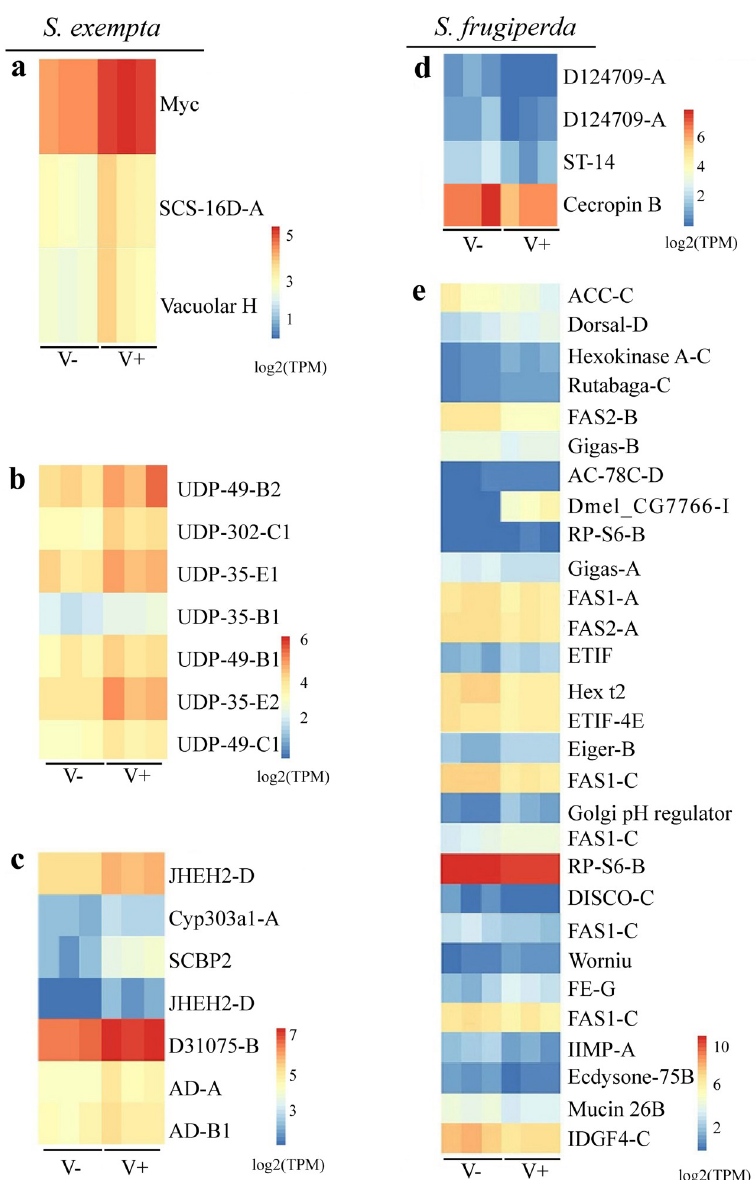
Fig 6. The quantity of DEGs with log2(TPM) related to the expression of different pathways. (a) the Jak-STAT signaling pathway of S . exempta larvae; (b) the Insect hormone biosynthesis pathway of S . exempta adult females; (c) the Steroid hormone biosynthesis pathway of S . exempta adult female; (d) the Toll and Imd signaling pathway of S . frugiperda larvae; and (e) the insulin signaling pathway expression of S . frugiperda adult females. Colors in log2(TPM) indicate the gene expression levels, the hotter (redder) the color, the higher the gene expression level. The original data for TPM are shown in S9